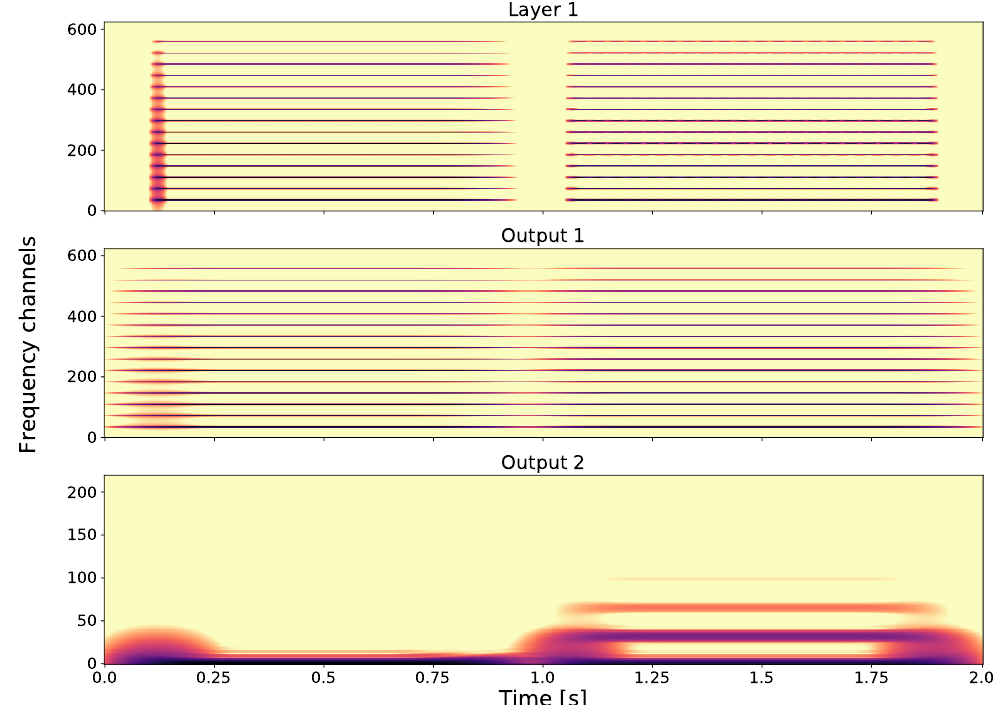
Figure 5. Layer 1 (i.e., GT), Output 1, and Output 2 of the signal having a sharp attack and afterwards some